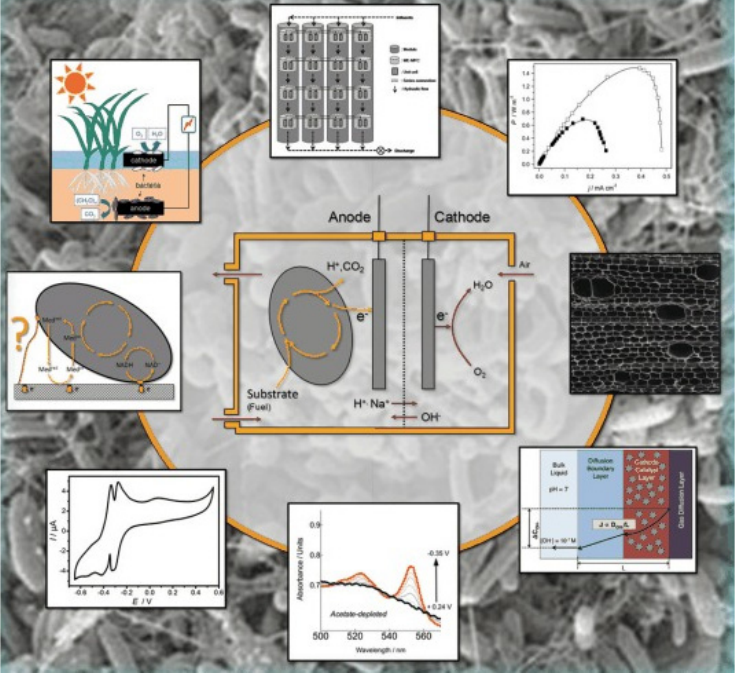
Figure 1. MFCs in the service of waste to energy conversion (Adapted with permission from Ref. [20]).